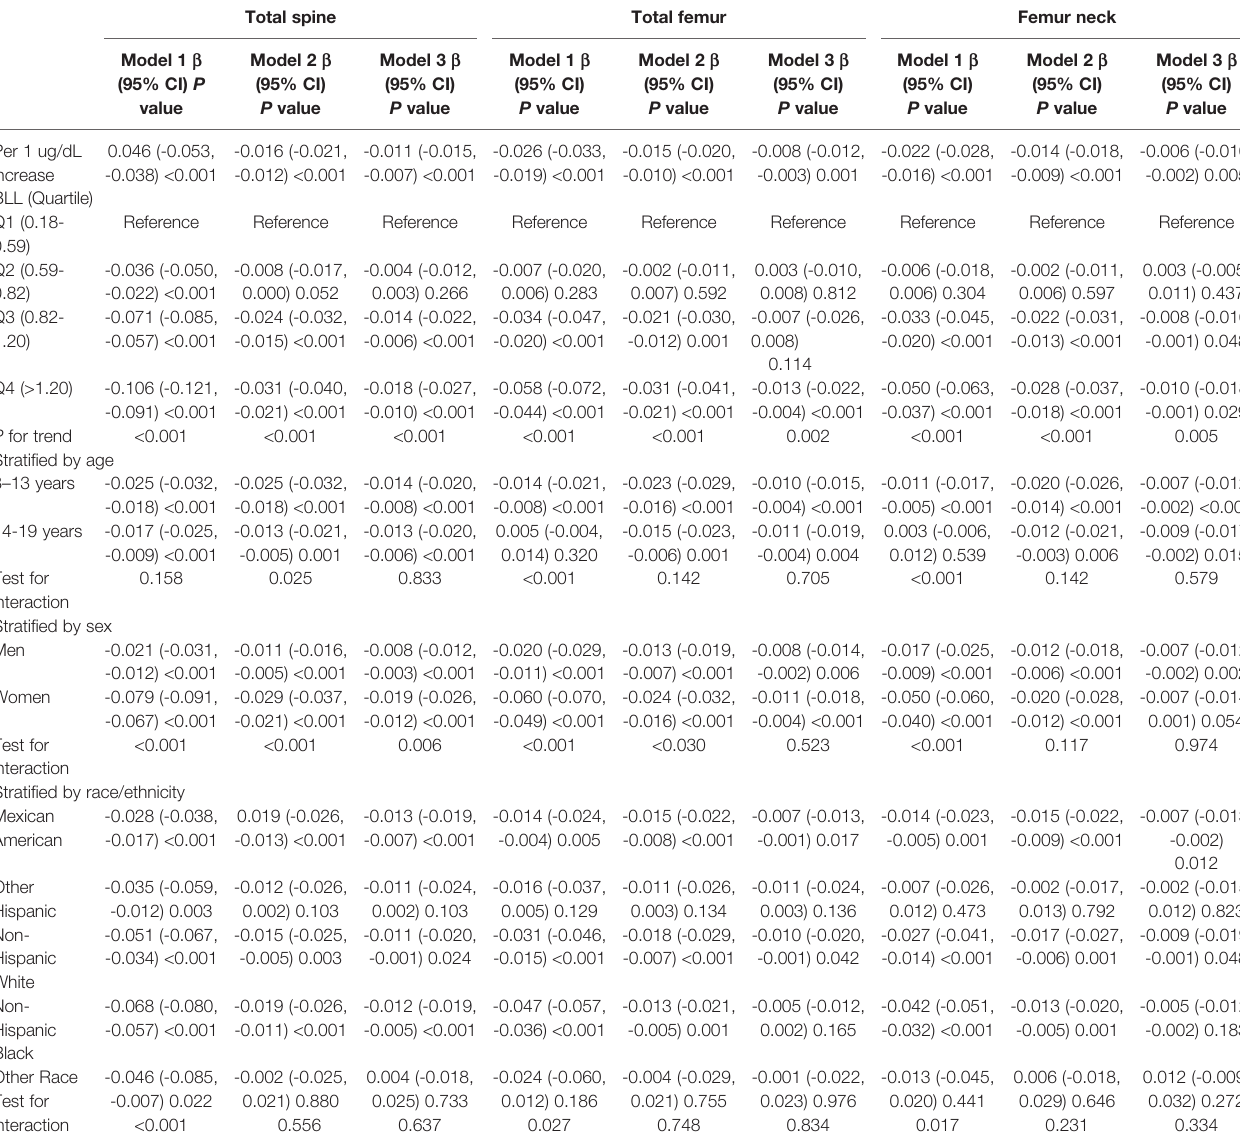
Model1unadjusted.Model2adjustedforage,gender,andrace/ethnicity.Model3adjustedforage,gender,andrace/ethnicity,PIR,bodymassindex,serumcalcium,serumphosphorus. BLL Blood lead levels. BMD bone mineral density. PIR poverty income